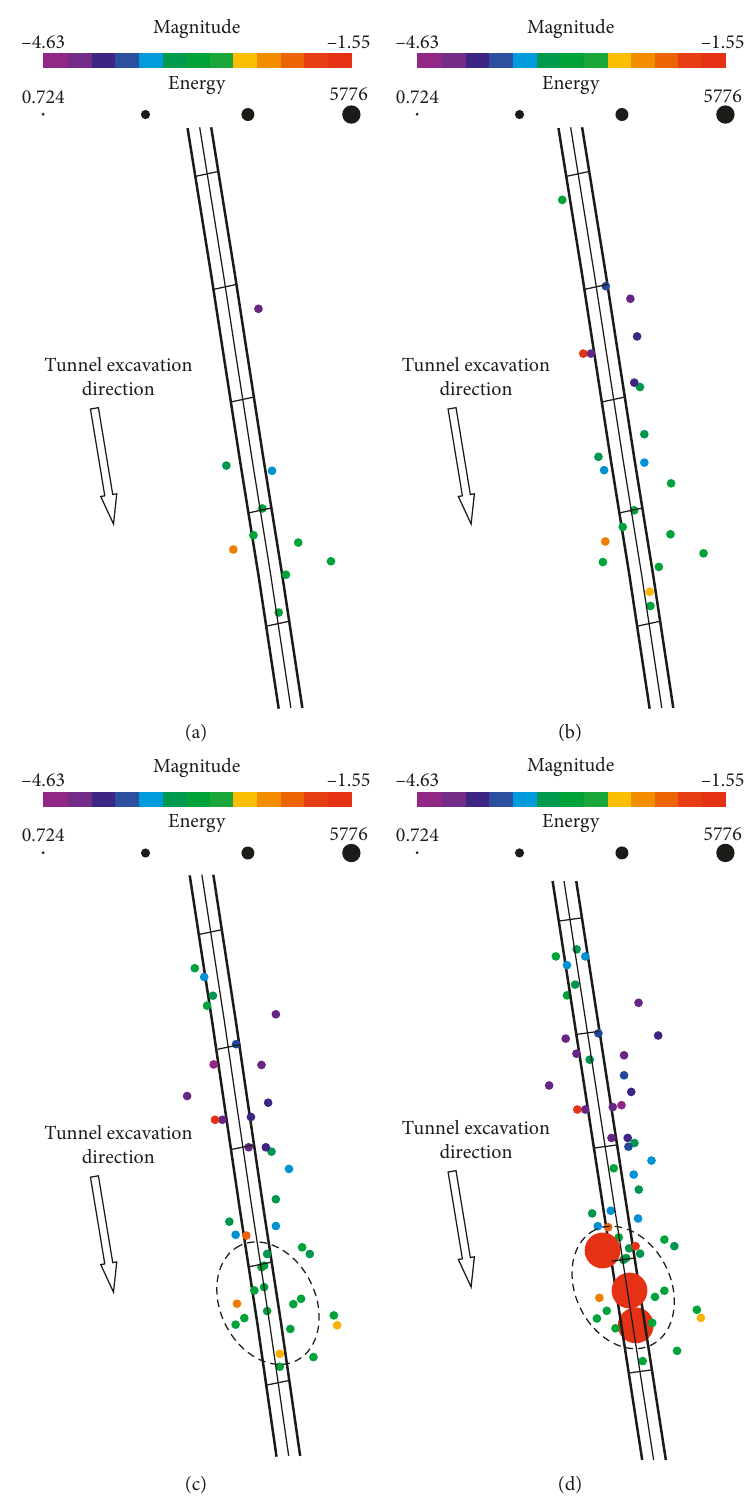
Figure 4: Schematic diagrams of the temporal, spatial, and magnitude distributions of microseismic activity during the excavation of the tunnel by drilling and blasting. (a) Distribution map of microseismic events on 4 ∼ 7 November 2017, (b) distribution map of microseismic events on 4 ∼ 10 November 2017, (c) distribution map of microseismic events on 4 ∼ 12 November 2017, and (d) distribution map of microseismic events on 4 ∼ 14 November